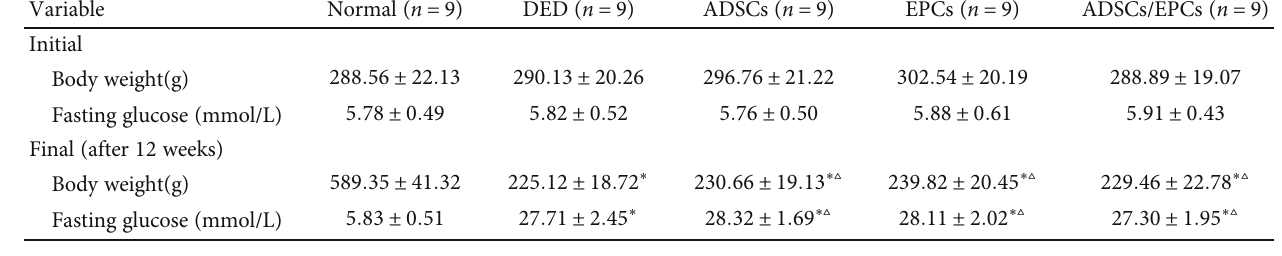
Table 1: The body weight and fasting glucose before and after cell transplantation in each group. Data are expressed as mean ± standard deviation from N = 14 per group. ∗ p < 0 : 05 vs the control group. ▵ p < 0 : 05 vs the DEM group.